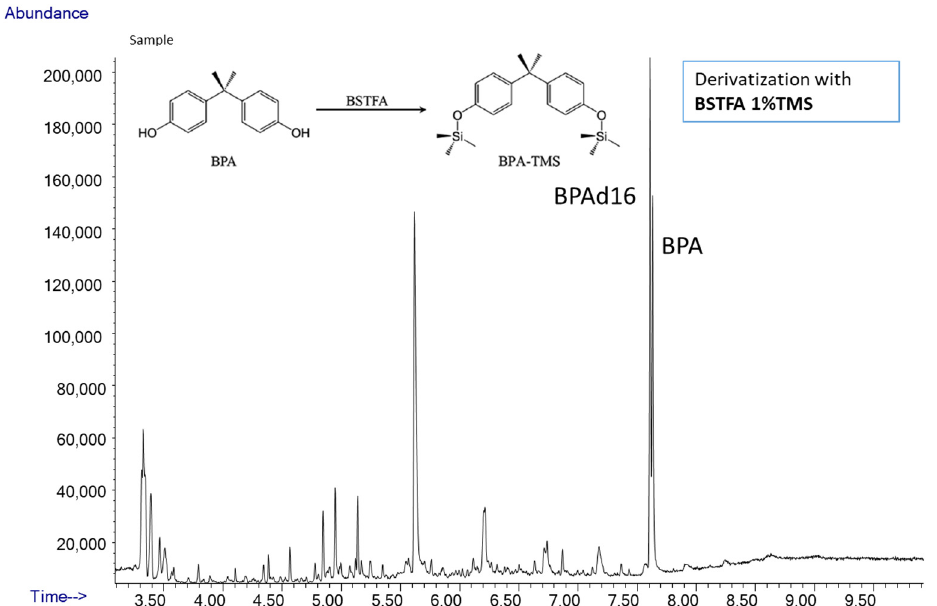
Figure 5. GC/MS TIC Chromatogram of total BPA in a deconjugated urine sample. BPA and BPAd 16 were derivatized by TMS and the peak with 2 TMS groups was detected and quantified using fragment 357 m / z for BPA and 368 m / z for BPAd 16 in SIM mode. Molecular ions were detected with fragment target ions for identification (372 m / z for BPA and 386 m / z for BPAd 16 ).